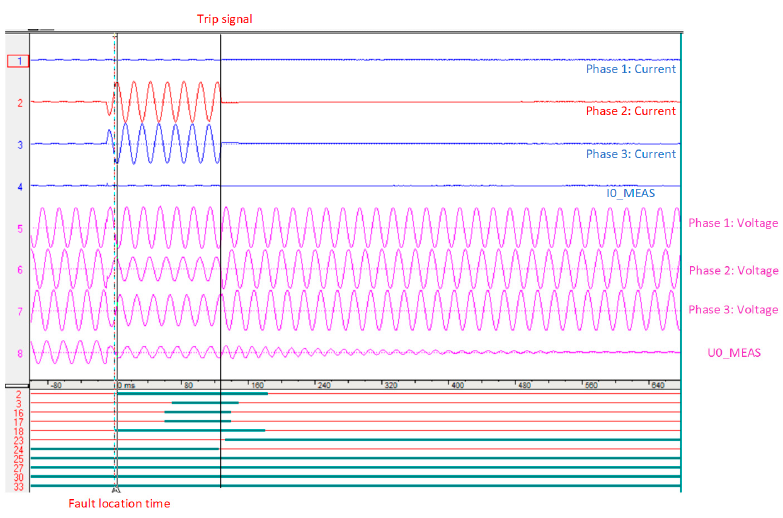
Figure 11. Real recorded fault current and voltage of distribution system.